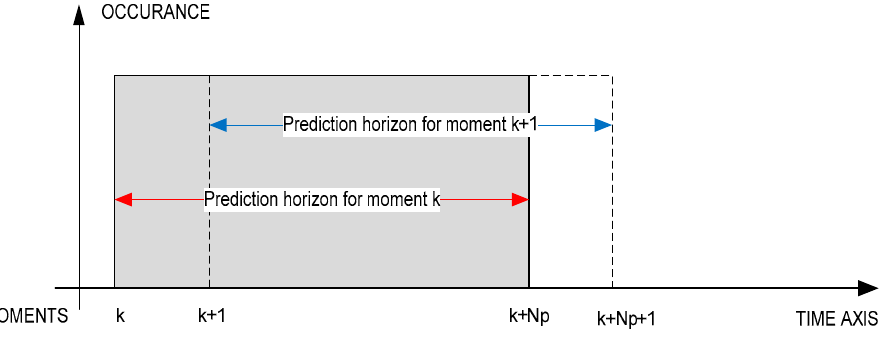
Figure 11. Prediction and Control Horizons.